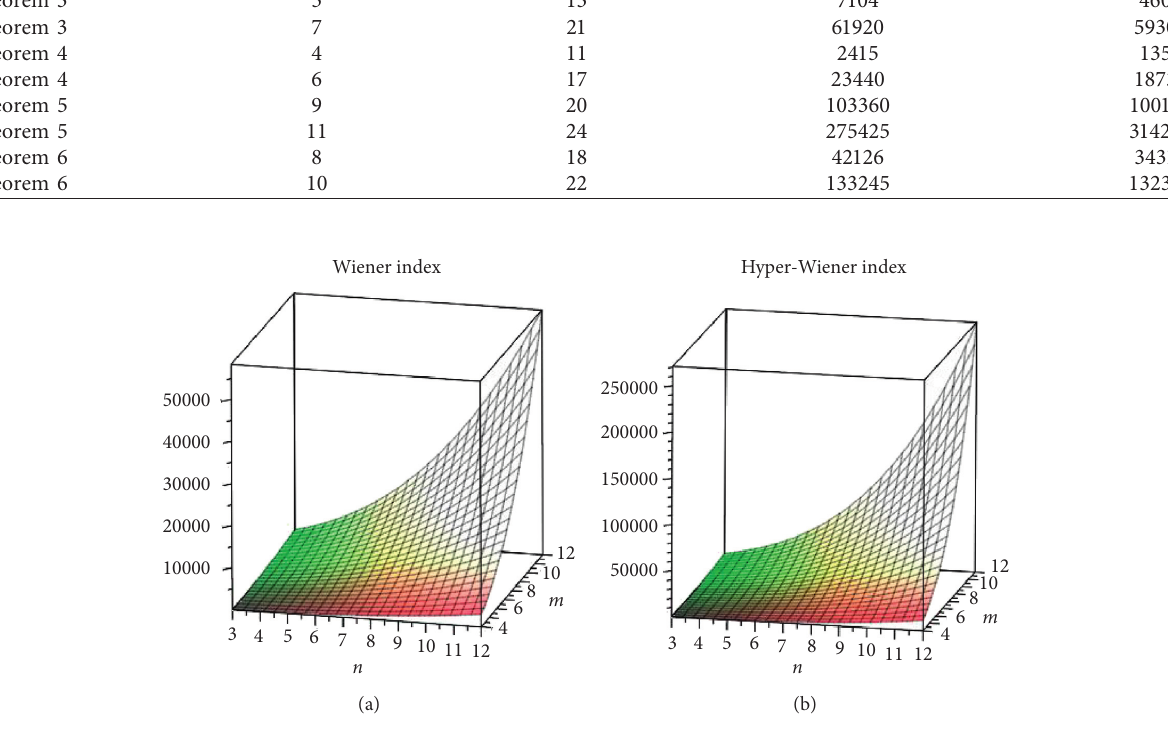
Figure 9: (a) Wiener index and (b) hyper-Wiener index for even m .